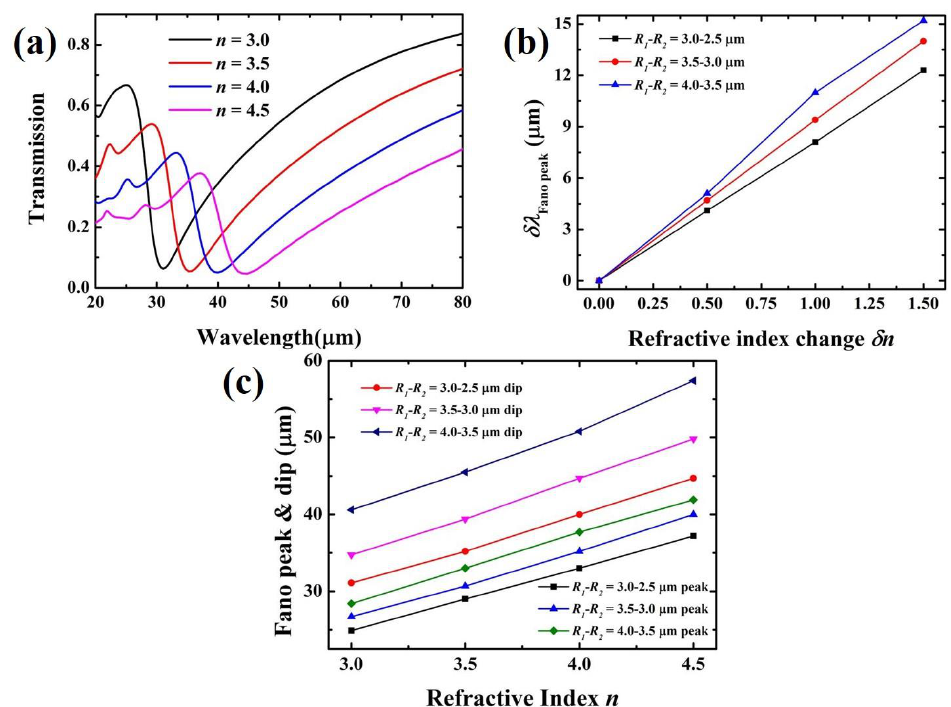
Figure 7. ( a ) Transmission spectra of the bowtie BP coupled with Au ring structure as a function of the refractive index of the substrate. The inner and outer radius of the ring is set as to 2.5 µ m and 3.0 µ m. ( b ) The shift of the Fano resonance peak as a function of the refractive index change δ n . ( c ) The peak-wavelength and dip-wavelength variations with the refractive index of the